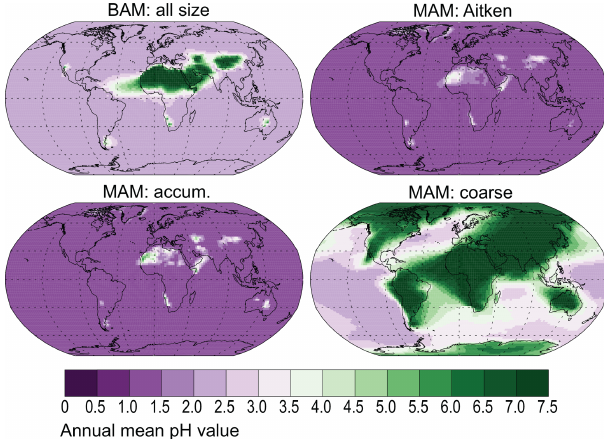
Figure 10. Surface-level annual mean interstitial aerosol pH. If [SO 4 ] > [calcite] then pH = 1 in Aitken and accumulation modes or 2 in coarse; otherwise, pH = 7.5 (Table